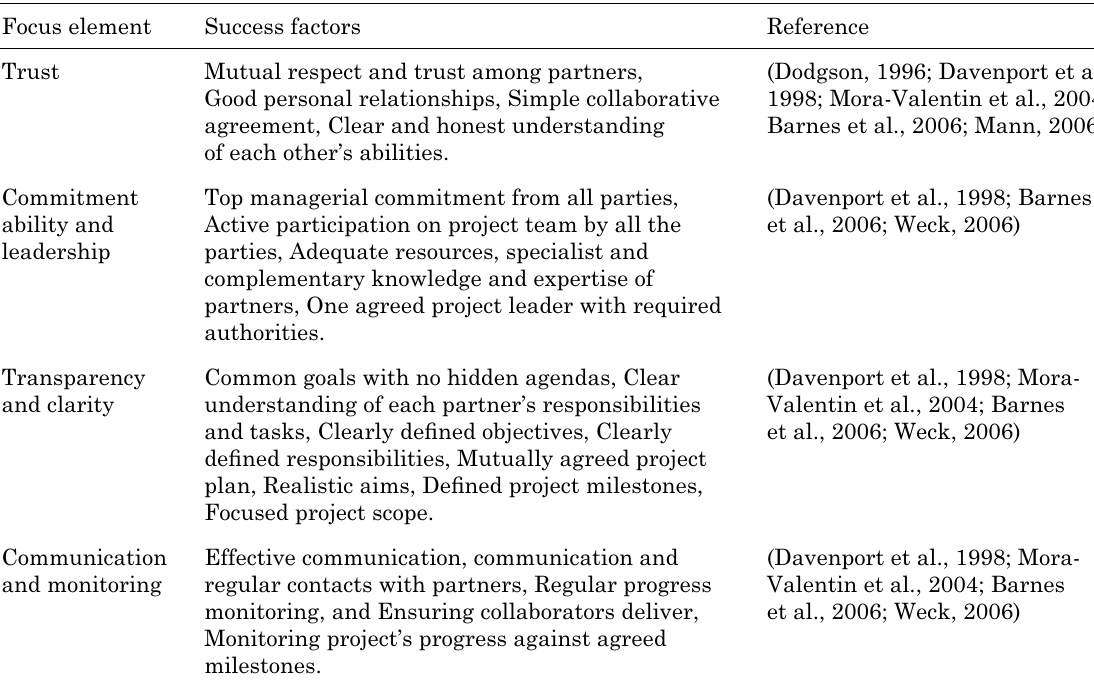
Table 1. Success factors of research collaborations Focus